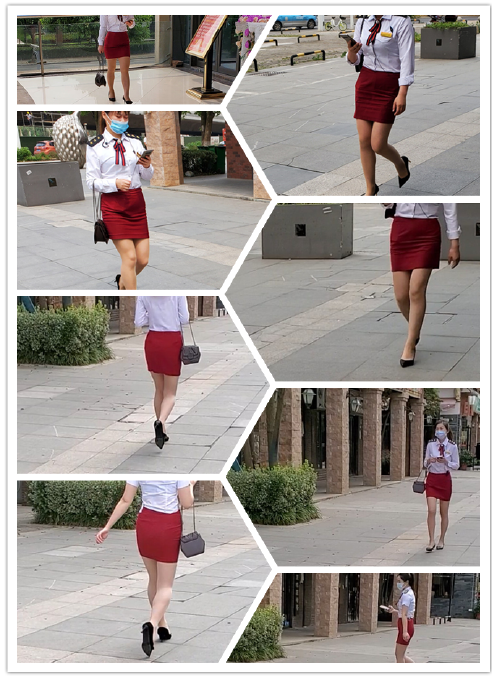
Figure 3. Photos of participants wearing Ultra HH.